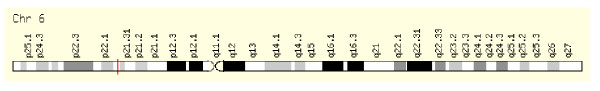
ApoM gene location in chromosome 6. ApoM gene is located in chromosome 6 p21.31 .